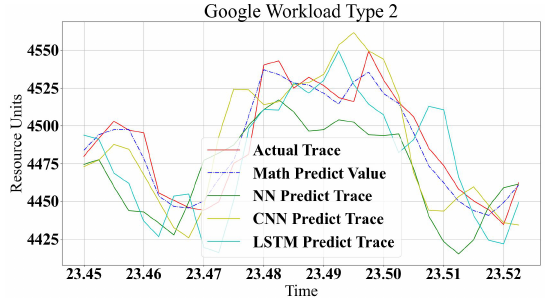
Figure 11. Google Workload Type